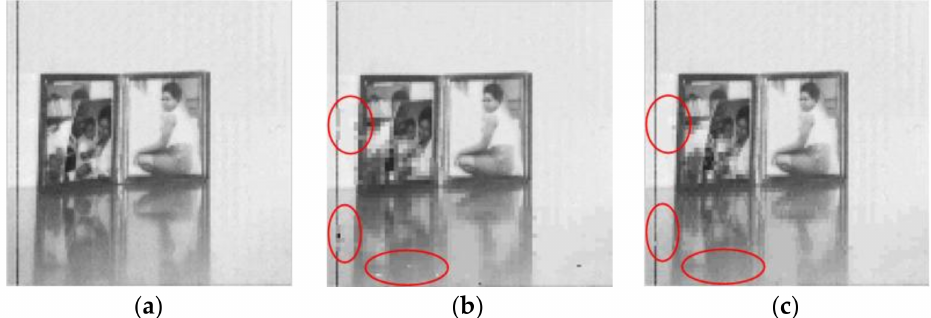
Figure 12. Partial enlarged details of the restored images: ( a ) Original image; ( b ) restored image using the method in [25]; ( c ) restored image of the proposed method. To highlight the differences between the restored images, some regions in restored images are selected and circled in